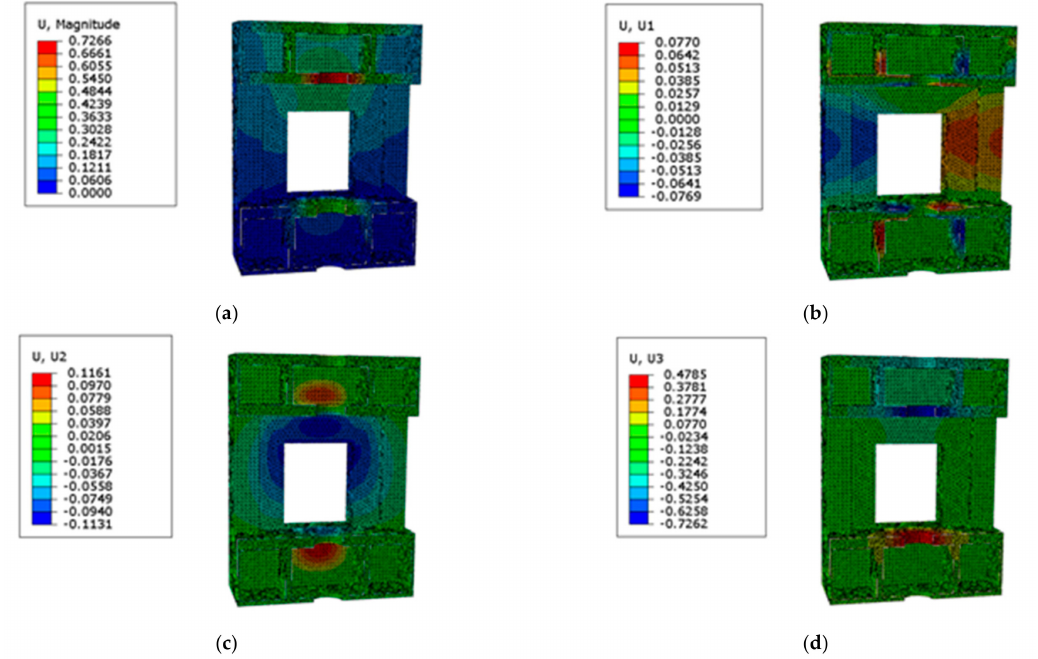
Figure 7. Main displacement ( a ), x-scale displacement ( b ), y-scale displacement ( c ) and z-scale displacement ( d ) of the COF